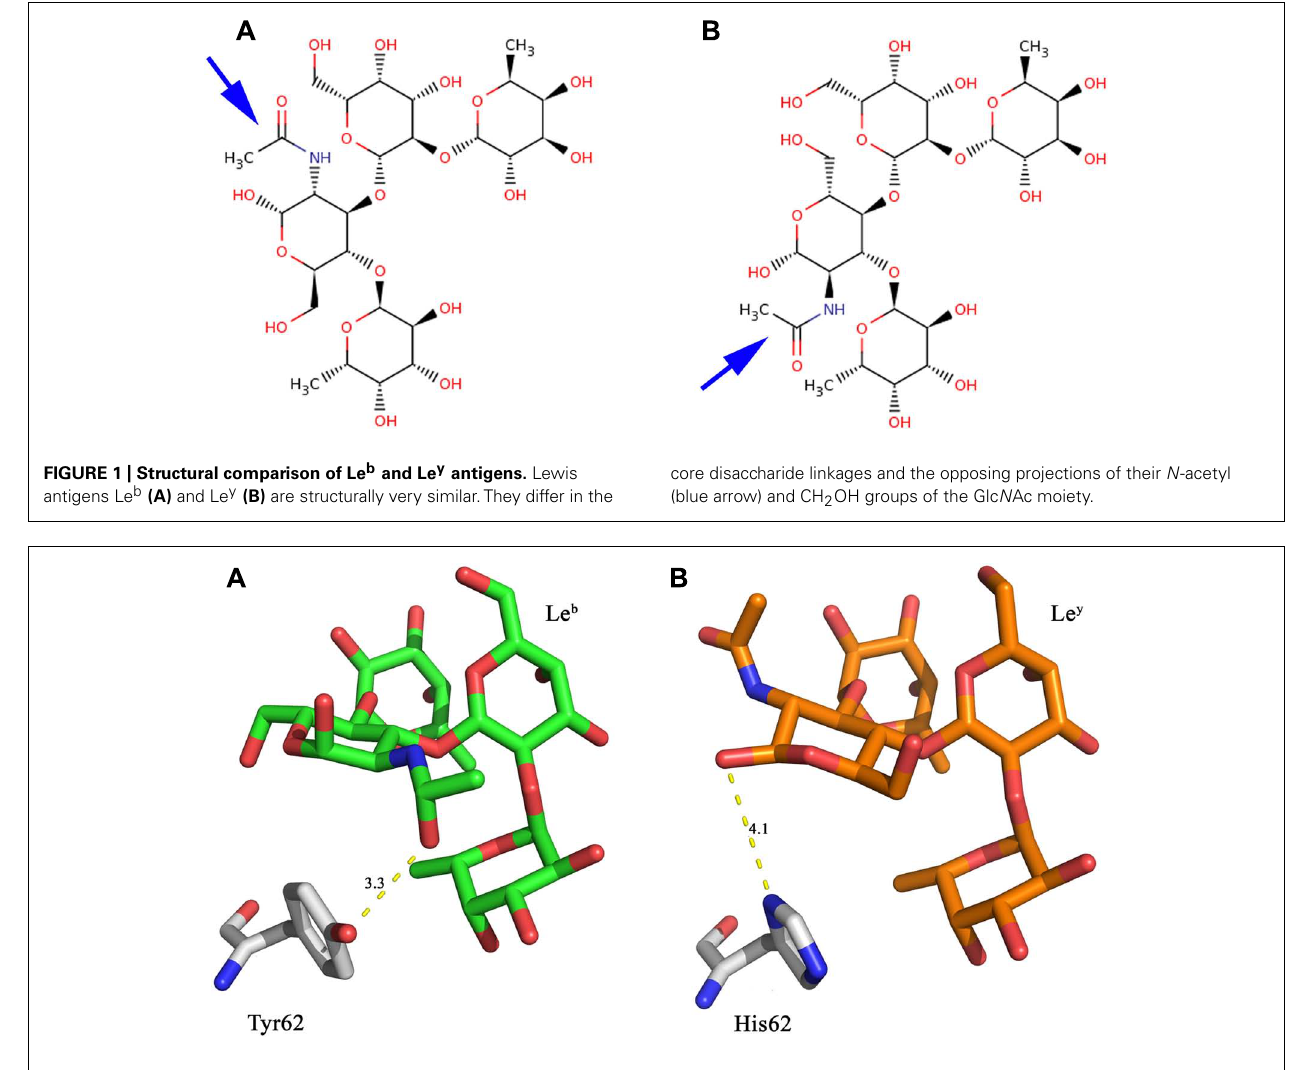
FIGURE 2 | In silico LLY lec Y62H mutant design. (A) Le b is within hydrogen bonding distance (3.3 Å) ofTyr62 from the LLY lec wt domain. (B) AY62H mutation was designed to retain similar structural properties to tyrosine, with the possibility that it may also result in a hydrogen bond to the Le y antigen.Yellow dashed lines denote hydrogen